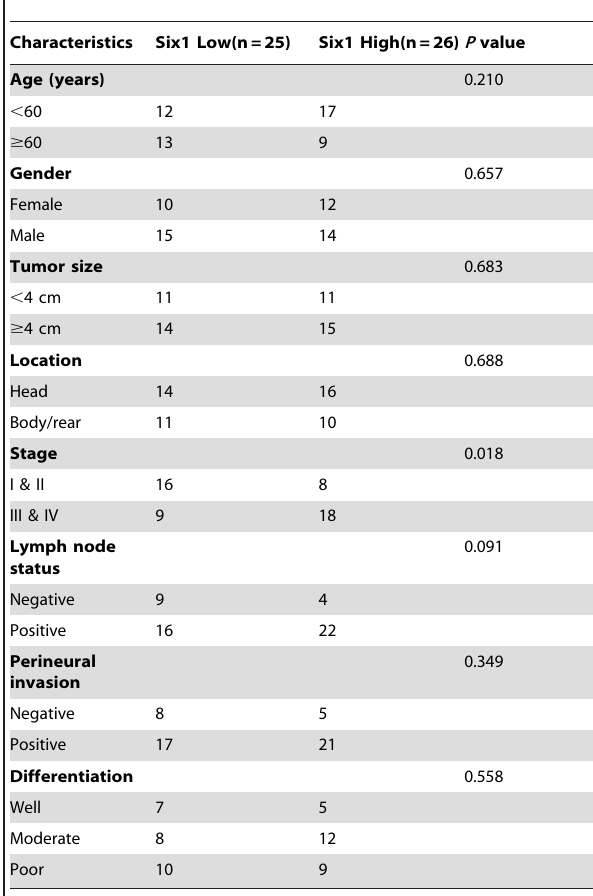
Table 1. Clinicopathological characteristics of patients according to the expression of